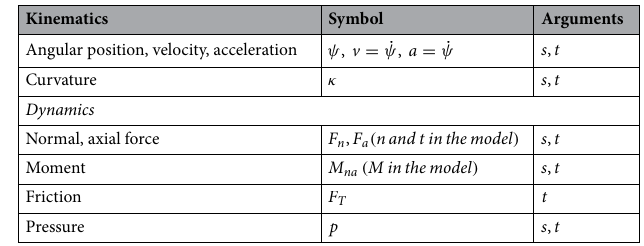
Table 2. List of all output parameters of the Cosserat and the friction